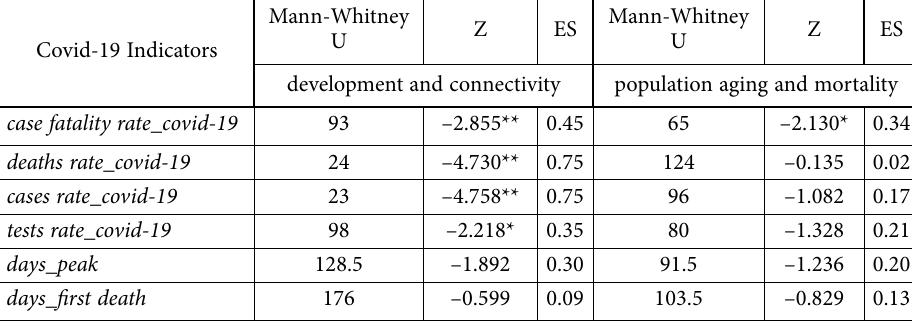
Table 7. The results of the Mann-Whitney U Test (source: authors’ computation using IBM SPSS Sta- tistics 21)